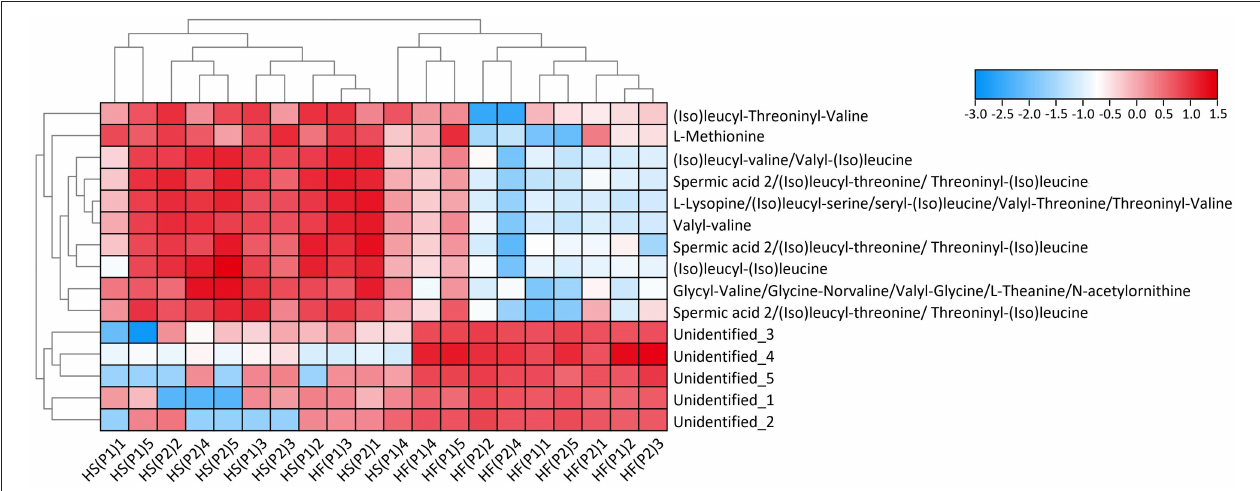
FIGURE 1 | Heatmap with cluster dendrogram of retrieved discriminative metabolites. Colors represent log-transformed peak intensity of metabolites. HF = high-fat diet, HS = high-starch diet, P1 = study period 1 and P2 = study period 2 for 5 dogs per